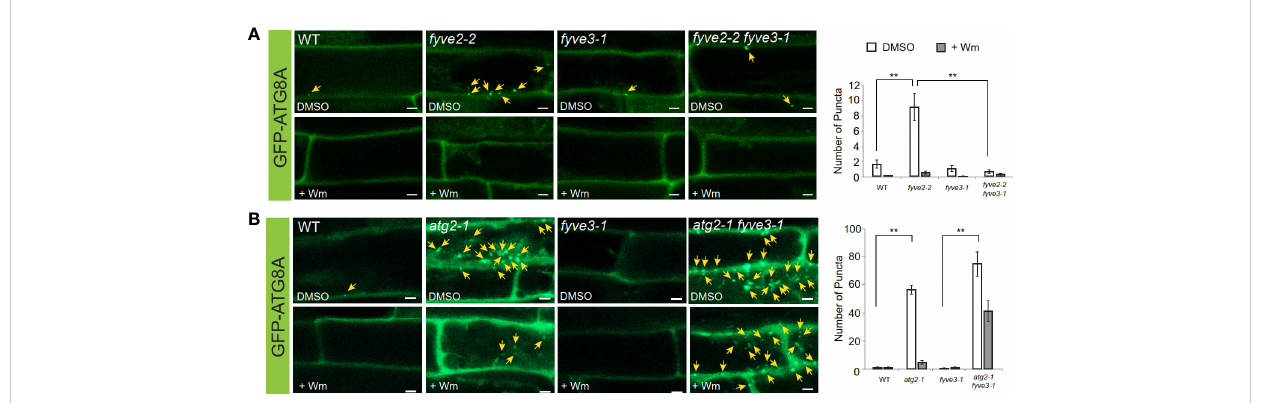
FIGURE 4 fyve3 suppresses the accumulation of autophagic puncta in fyve2 but not those in atg2 . (A, B) Representative confocal microscopy images (left) and quanti fi cation (right) of GFP-ATG8A puncta (arrows at the images) acquired from mature root cells with indicated genetic background. Transgenic Arabidopsis seedlings expressing GFP-ATG8A were incubated in a nitrogen-lacking liquid media for 48 h and treated with either wortmannin (Wm) or solvent control (DMSO) for 1 h prior to image acquisition. Scale bars = 5 µm. Columns marked with asterisks represent means that signi fi cantly differ from each other, according to the t -test. Mean ± S.E.; n = 12 to 26 images; **p <